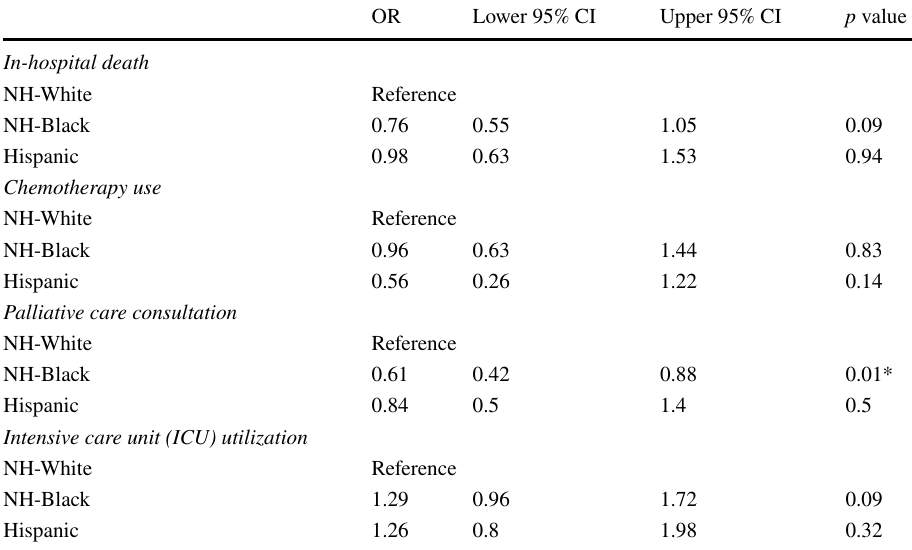
Models are adjusted for patient’s gender, age, income quartile, primary payer